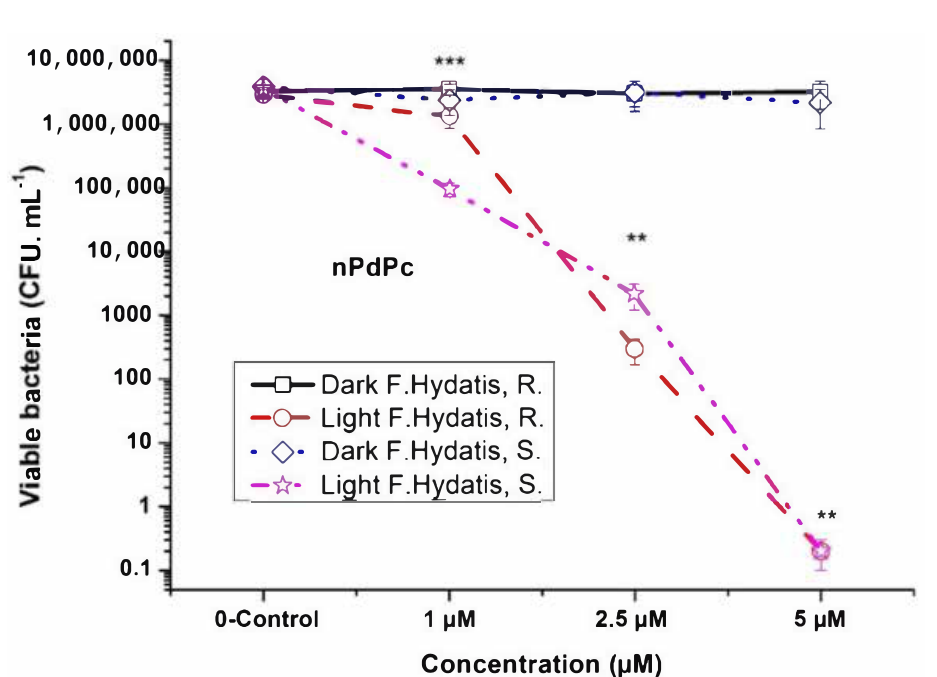
Figure 2. Photodynamic inactivation of F. hydatis (R and S) planktonic cultured with